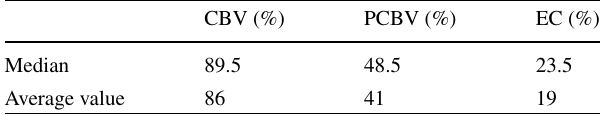
Table 6 Descriptive statistics of calcification score